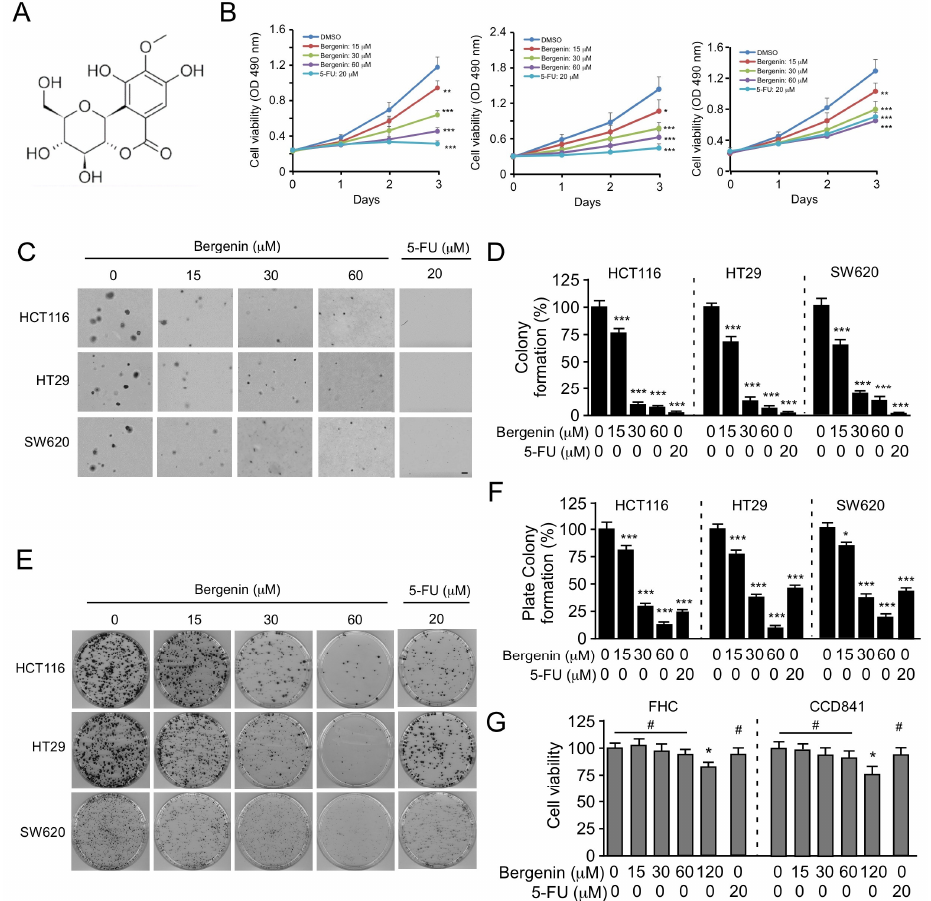
Figure 1. Bergenin inhibits proliferation of CRC cells. The chemical structure of bergenin is shown in ( A ). ( B ) Cell viability analysis of HCT116 (left), HT29 (middle), and SW620 (right) cells was evaluated using the MTS assay following bergenin or 5-Fu treatment. 5-Fu was used as positive control. Data are represented as mean ± SD (n = 3). * p < 0.05, ** p < 0.01, *** p < 0.001. ( C , D ) Colony formation of bergenin-treated or 5-Fu-treated HCT116, HT29, and SW620 cells was analyzed by the soft agar method. 5-Fu was used as positive control. ( C ) Colony formation images. Scale bar, 200 µ m. ( D ) Quantification. Data are represented as mean ± SD (n = 3). *** p < 0.001. ( E , F ) The plate colony formation of HCT116, HT29, and SW620 cells following bergenin or 5-Fu treatment. 5-Fu was used as positive control. ( E ) Colony formation images. ( F ) Quantification. Data are represented as mean ± SD (n = 3). * p < 0.05, *** p < 0.001. ( G ) Cell viability of immortalized FHC and CCD841 non-tumor cells following their treatment with bergenin or 5-Fu for 72 h was analyzed separately by the MTS method. 5-Fu was used as positive control. Data are represented as mean ± SD (n = 3). * p < 0.05, #, not statistically significant. CRC, colorectal cancer; MTS,